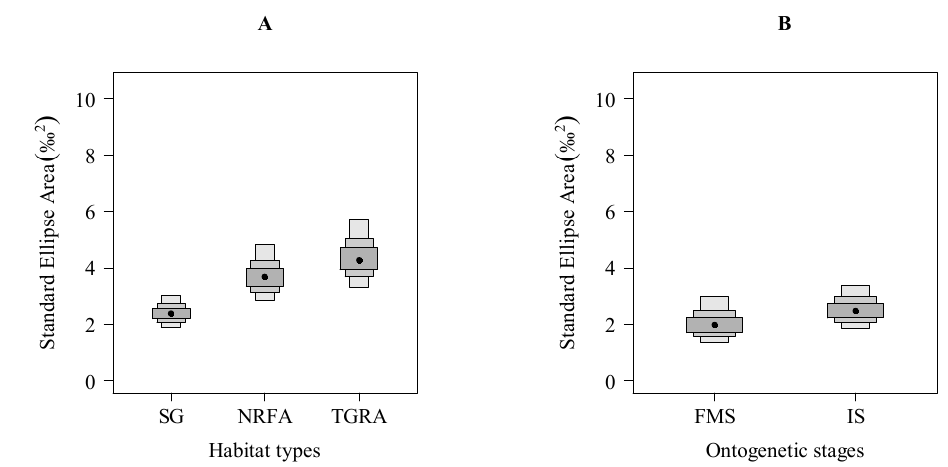
Figure 4. Variation in isotopic width (SEA B ) among three habitat types ( A ) and between two ontogenetic stages ( B ) (SG: spawning ground; NRFA: the natural riverine feeding and nursery area; TGRA: The Three Gorges Reservoir area; FMS, fully mature stage; IS, immature stage; boxes represent the 50, 75 and 95% Bayesian credibility intervals).